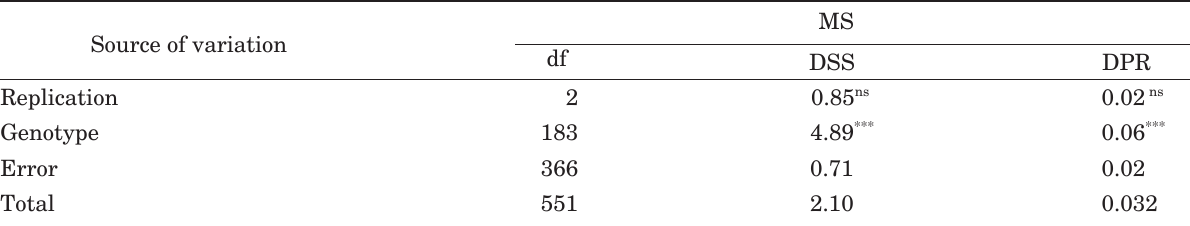
Table 1. Analysis of variance for the disease severity score (DSS) and the disease progress rate (DPR) in 184 sun- flower genotypes inoculated with Phoma macdonaldii isolate MP6 in controlled